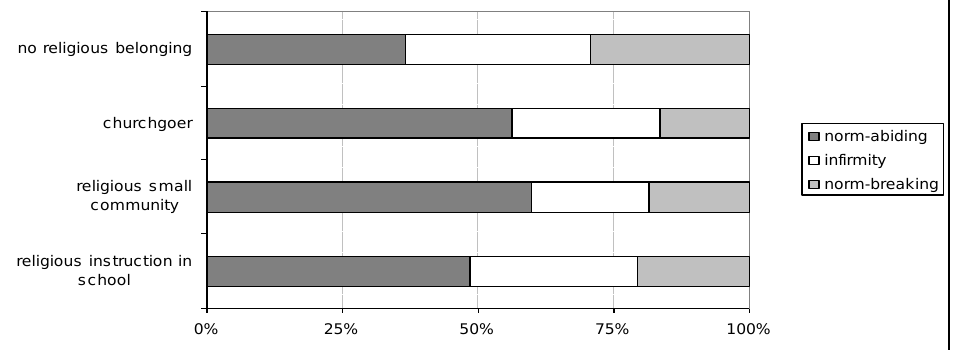
Source: The Impact of Tertiary Education on Regional Development I. N =